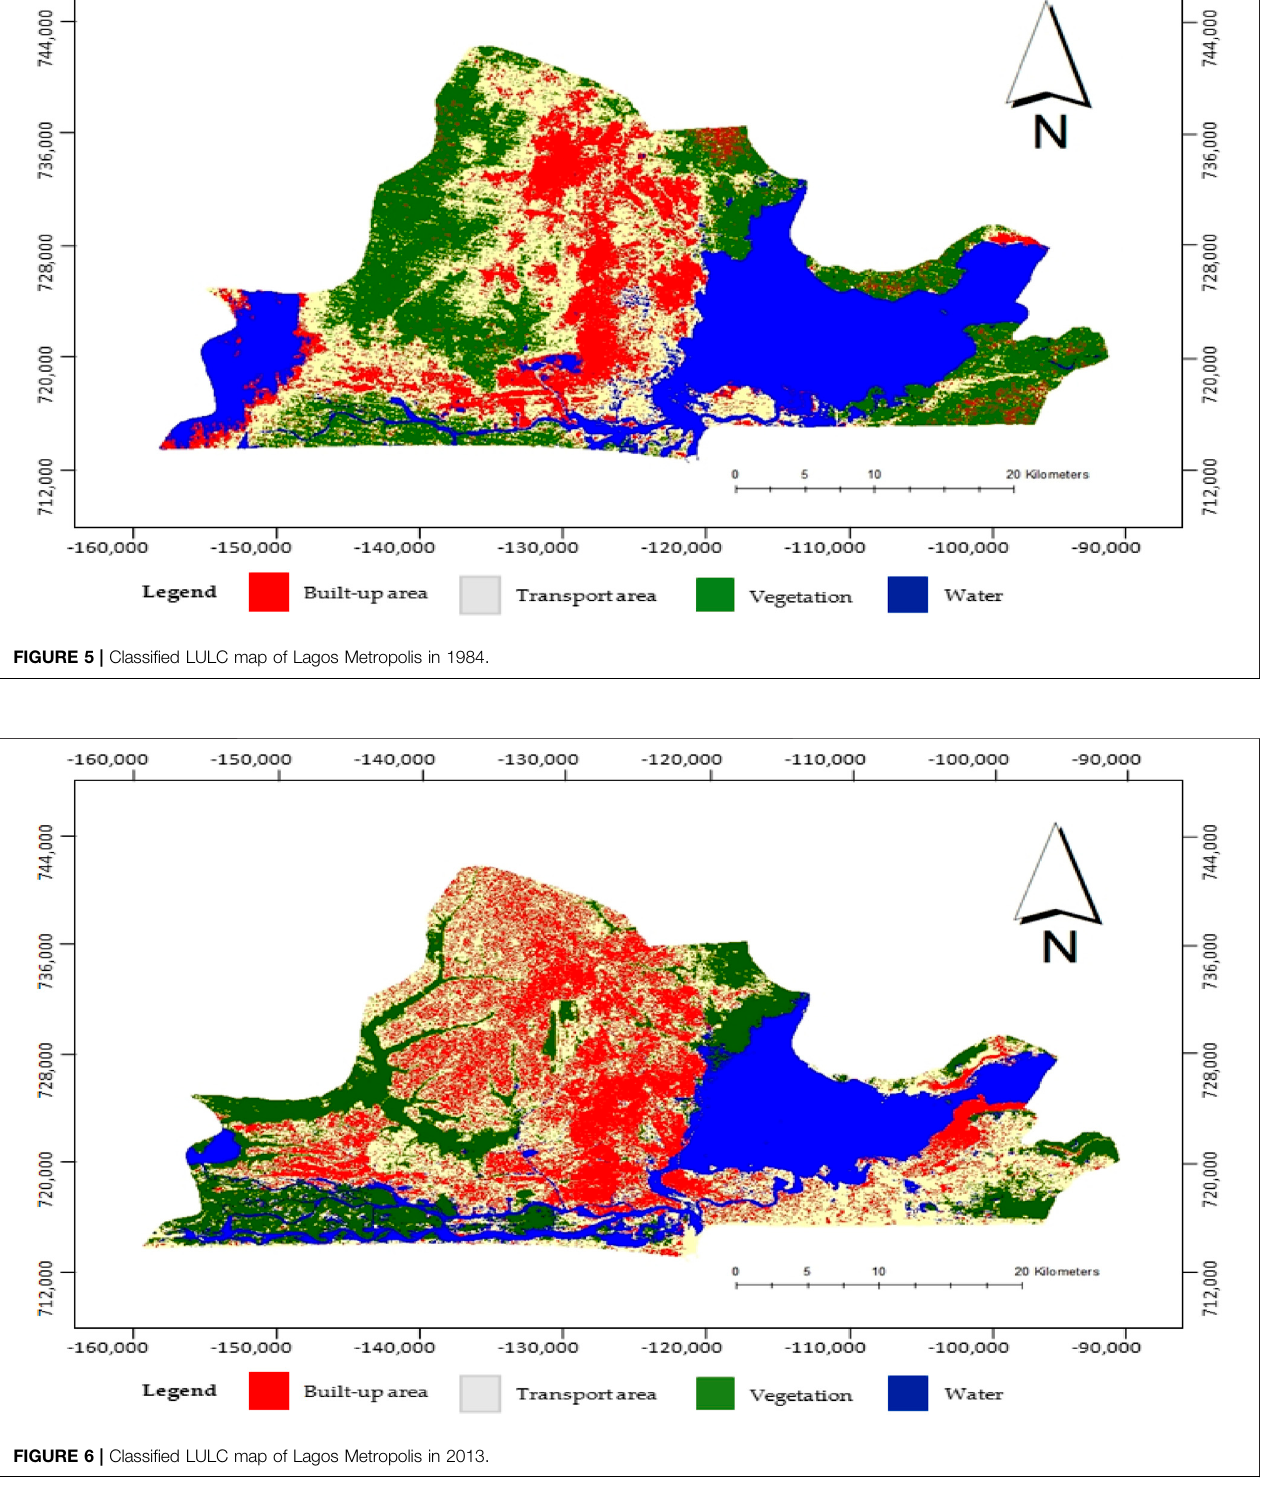
Frontiers in Future Transportation |